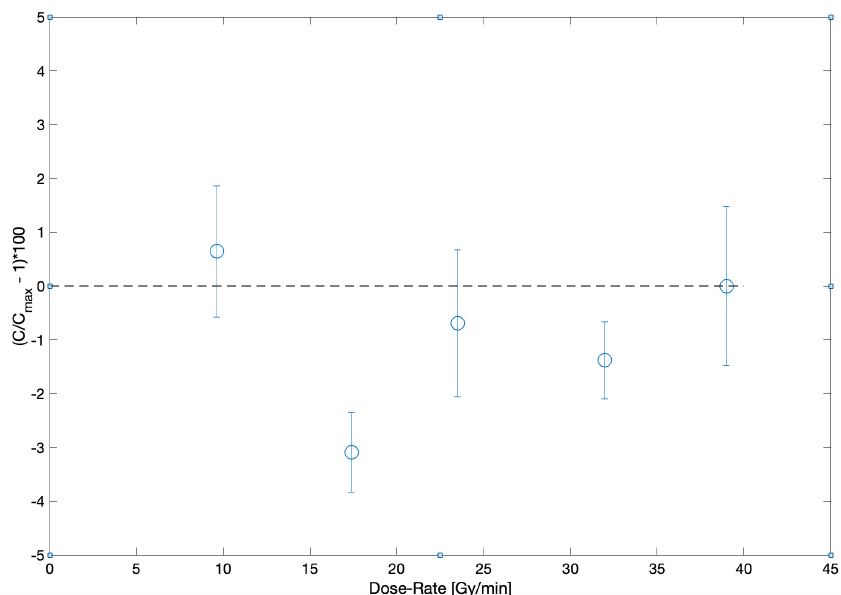
Figure 5. Percentage variations, with respect to the value measured at the maximum dose rate (39 Gy/min) of the collected charge for growing values of beam